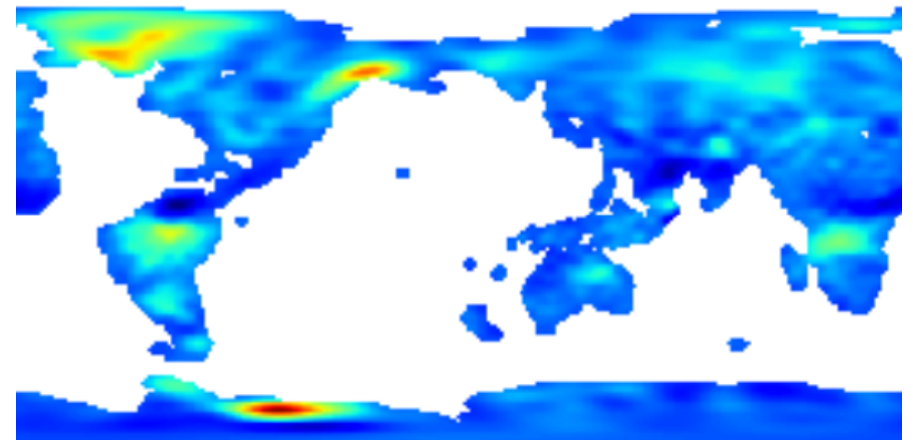
Figure 2. A sample full image of the GRACE groundwater dataset used in this research